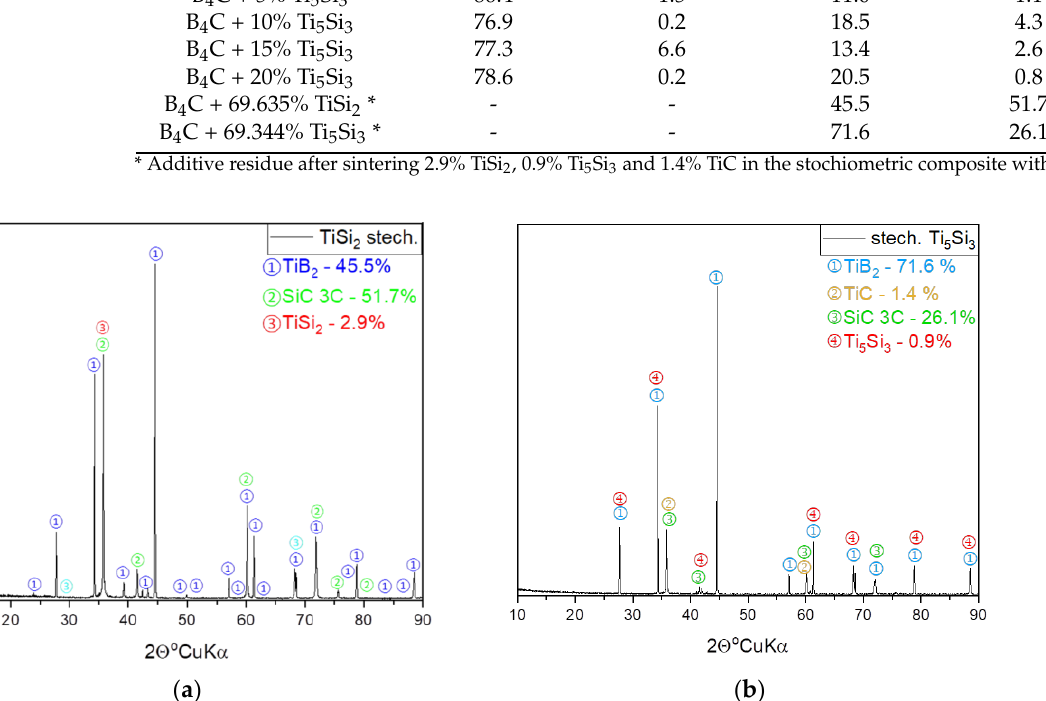
Figure 6. Diffractograms for the composites obtained from the stoichiometric samples in which the addition of the intermetallics was: ( a ) TiSi 2 , ( b ) Ti 5 Si 3.